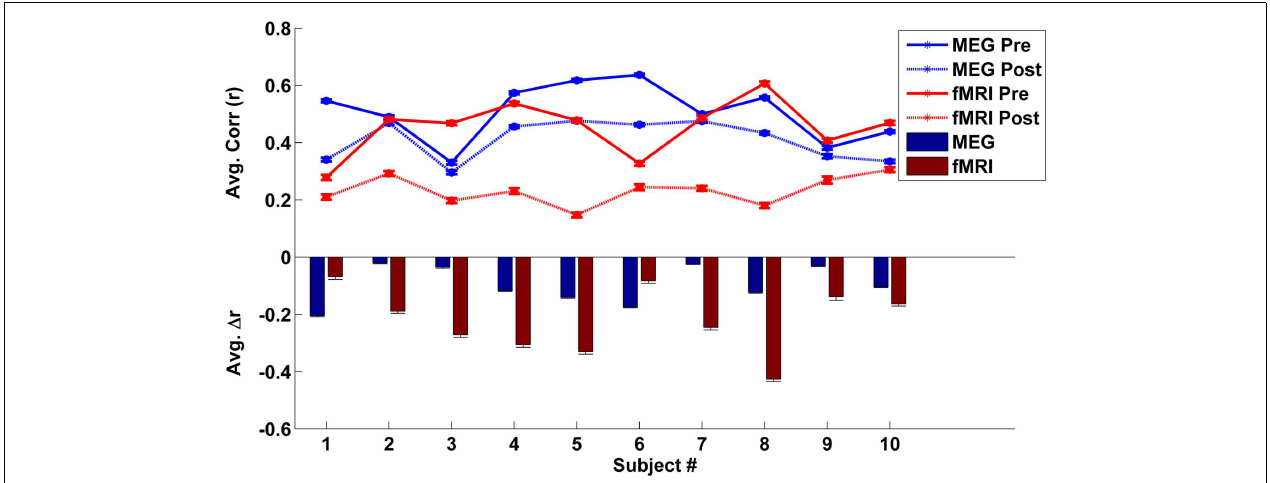
mean global correlation (post-dose section minus pre-dose section) for the MEG (blue) and the fMRI (red) caffeine sessions. Although all subjects exhibited a decrease in overall connectivity for both modalities, the magnitudes of the MEG and fMRI decreases were not significantly related. Error bars represent the standard error across